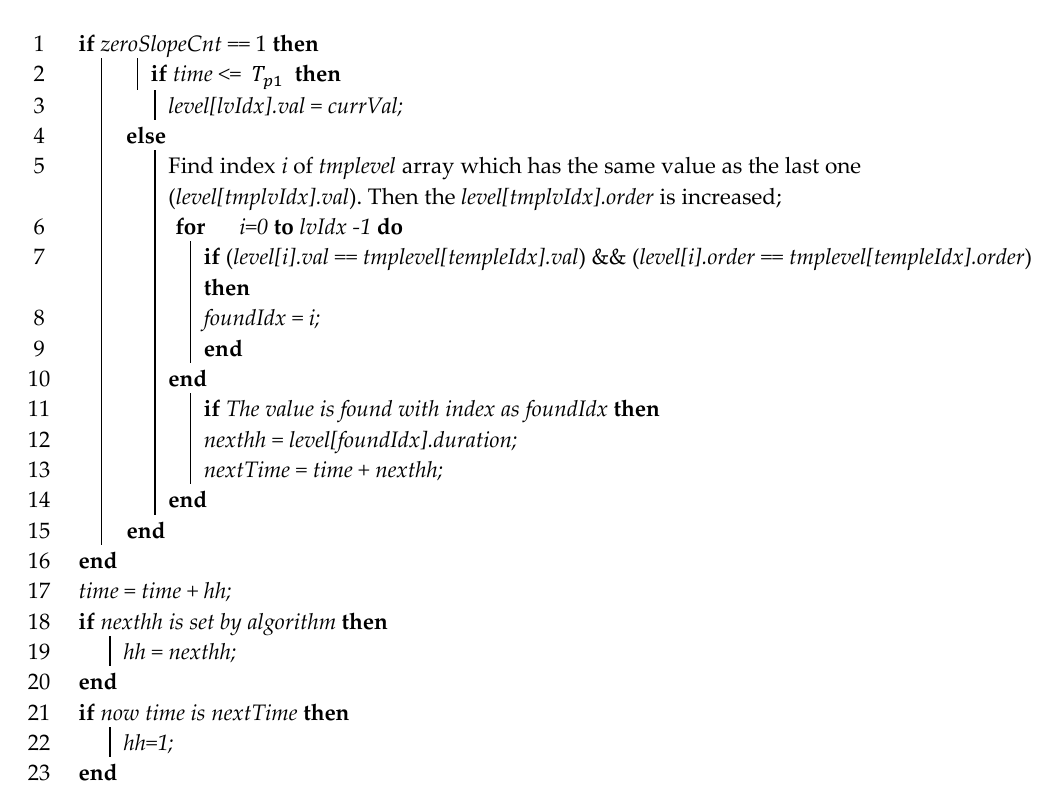
Algorithm 2: adaptive step size algorithm (search of level patterns and step size